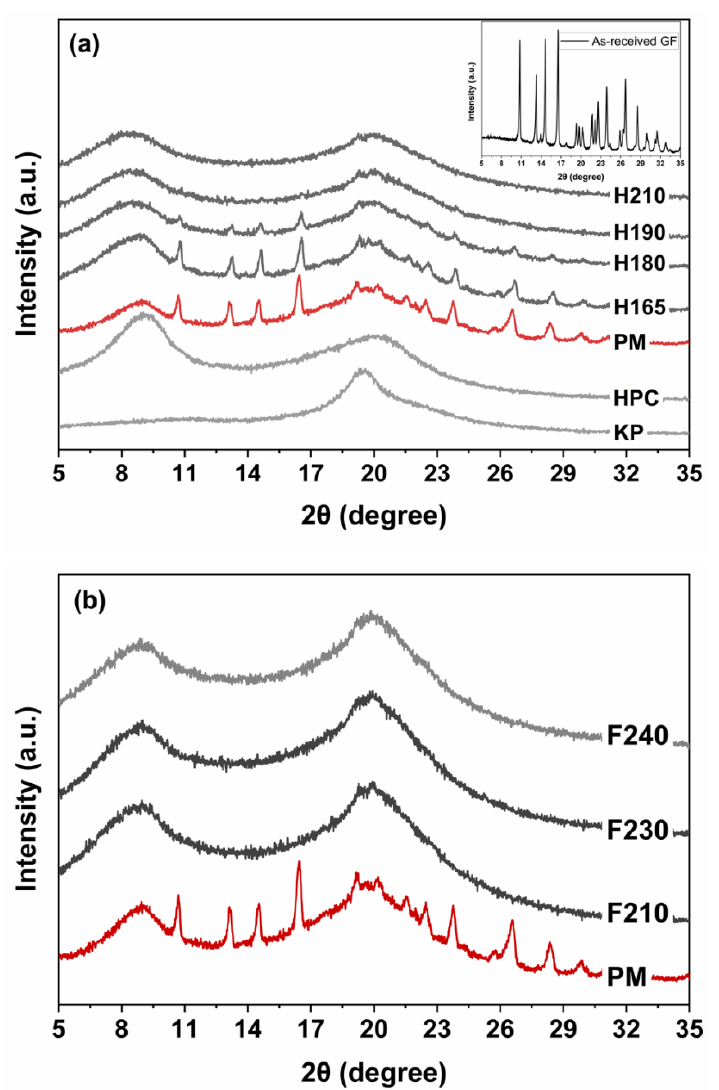
Figure 3. XRPD pattern of ( a ) as-received GF, physical mixture (PM), filaments through H165-210 and ( b ) 3D printed tablets,